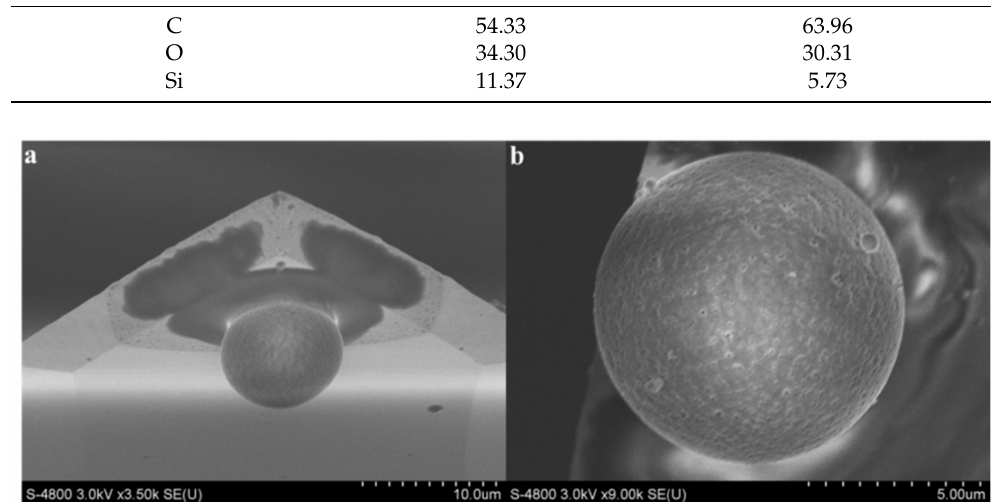
Figure 2. Morphology of SiO 2 sphere covered with heavy oil ( a ) vertical view; ( b ) front